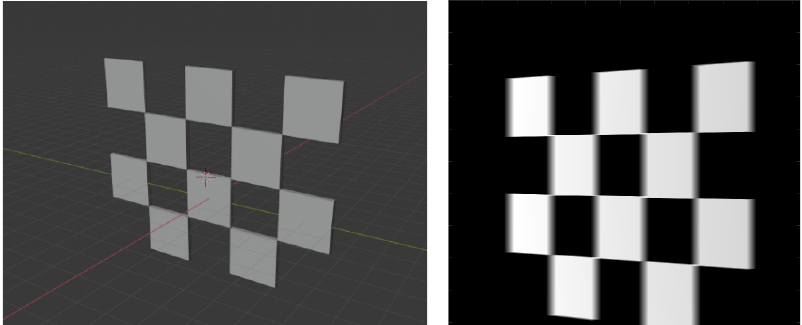
Figure 5. A 3D view of calibration board in Blender ( left ). A projection of the board ( right ).